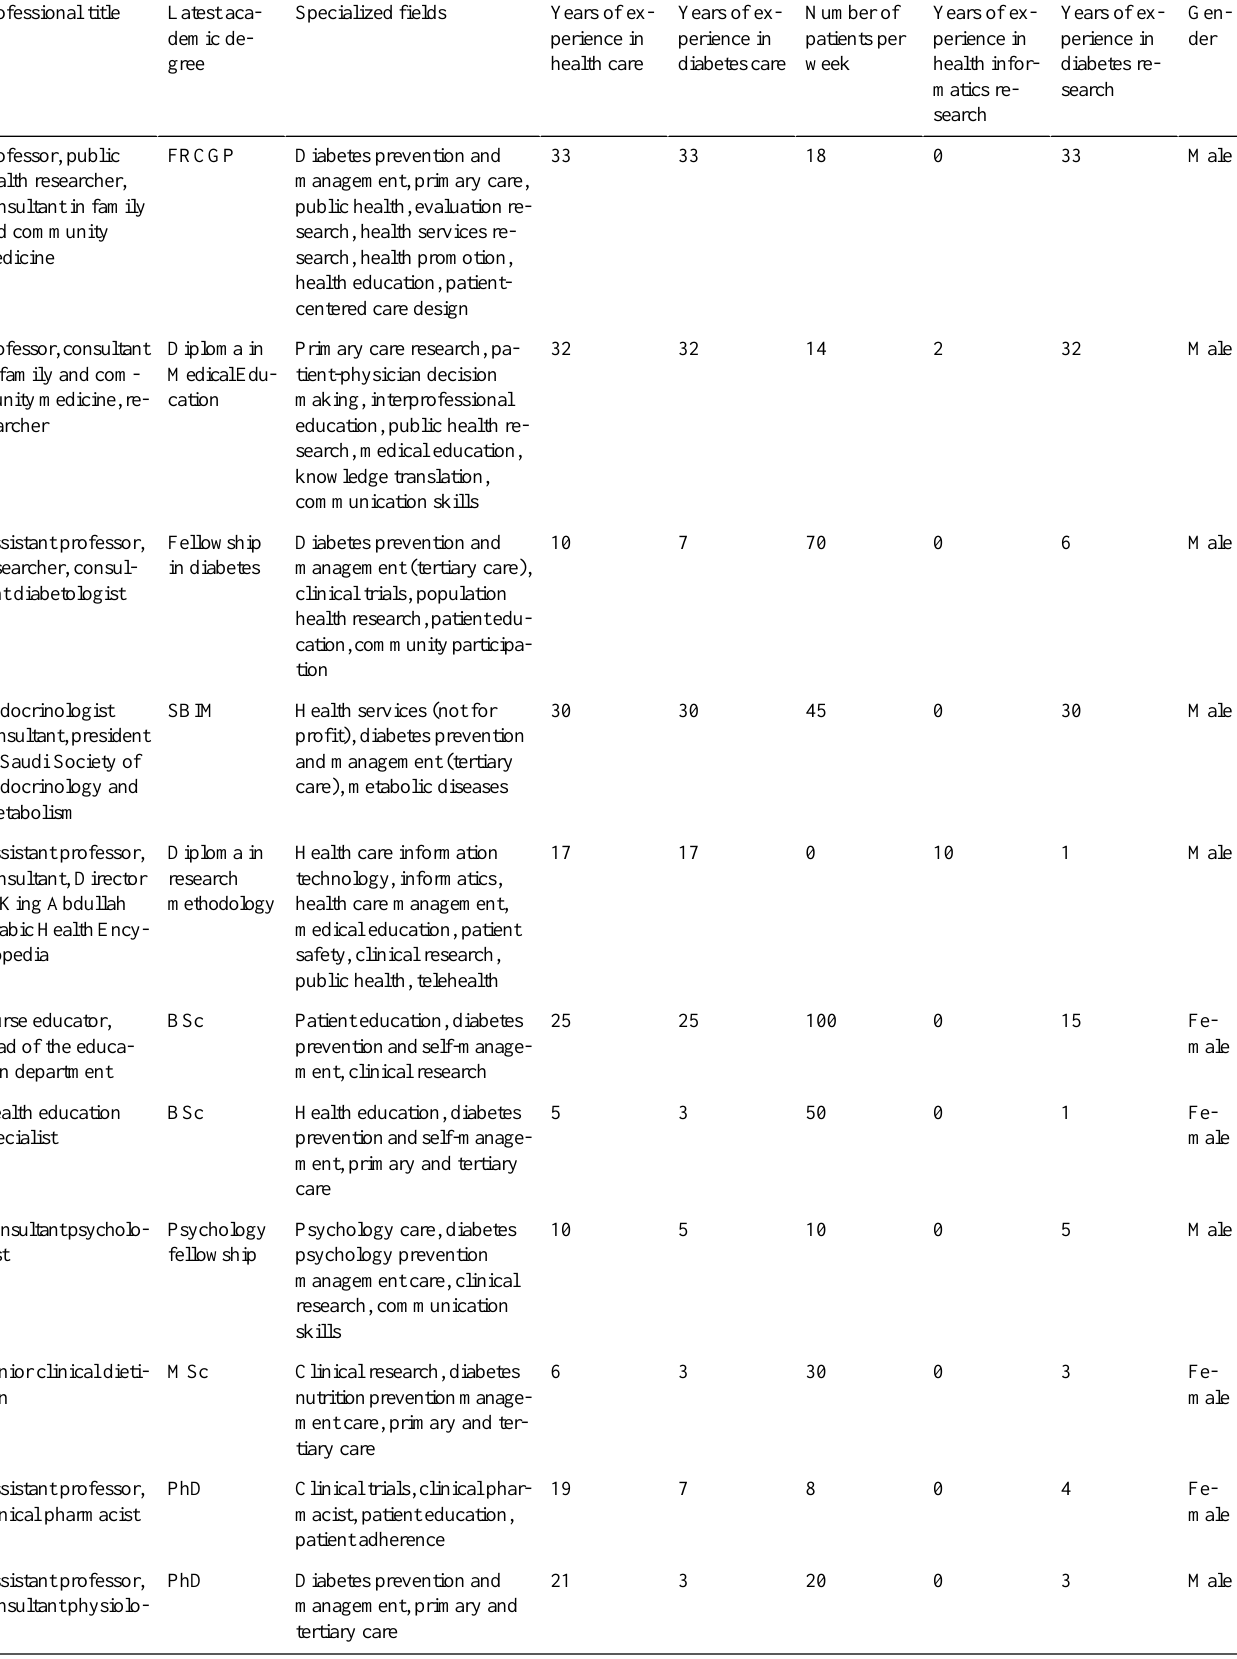
Table 1. Profiles of the expert panel members (N=11).